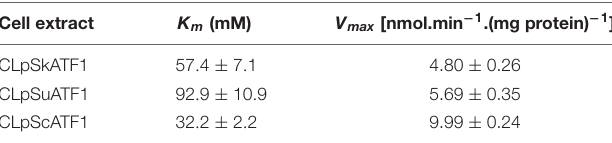
TABLE 4 | The kinetic parameters of SkAtf1p, SuAtf1p, and ScAtf1p measured in the cell extracts of the S. cerevisiae strain with atf1 atf2 iah1 deletion.